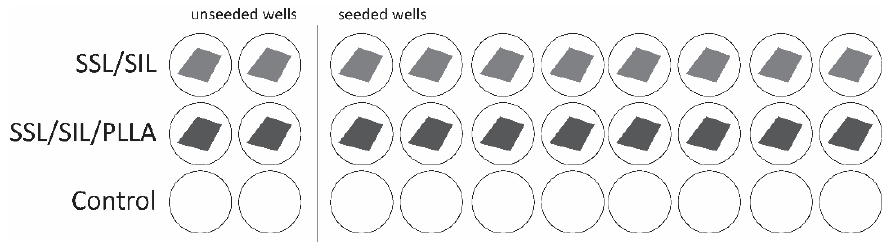
Figure 9. Layout of the experimental set for the in vitro cytocompatibility